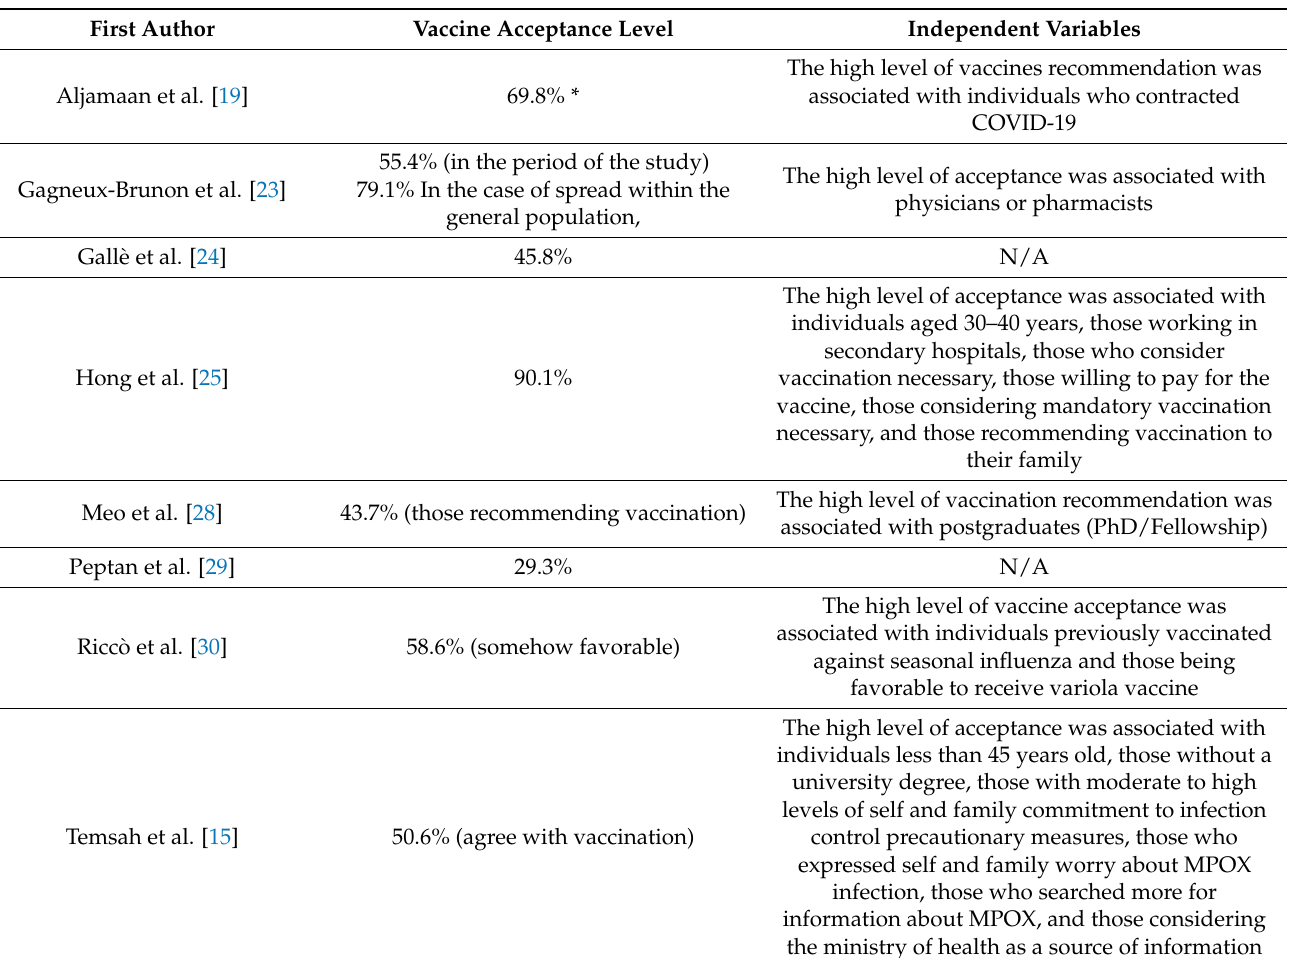
Table 3. MPOX-related Vaccine Attitudes According to the Included